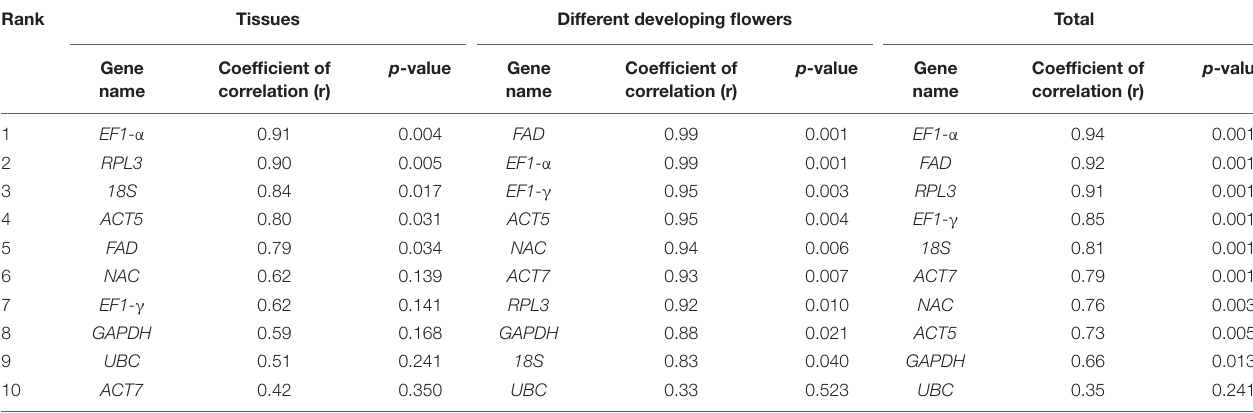
TABLE 3 | Expression stability values of ten selected genes determined through BestKeeper.